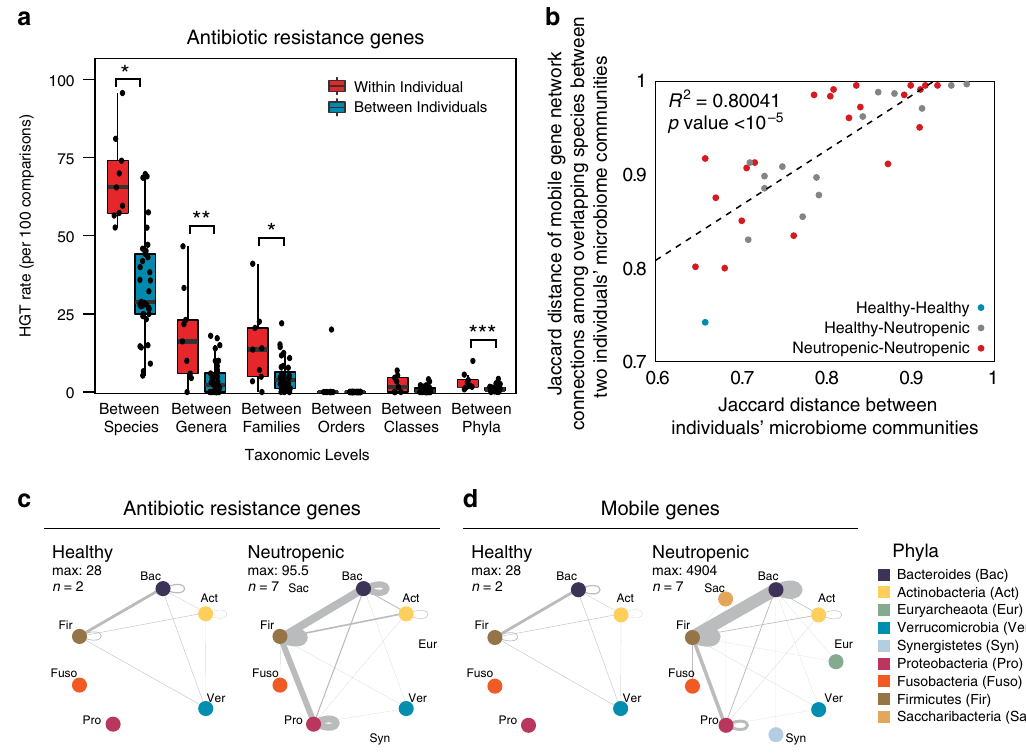
Fig. 2 Networks of bacterial HGT are unique to each individuals ’ gut microbiomes. a HGT rates (per 100 comparisons) of AR genes between organisms within each individual ( n = 9) versus between individuals ( n = 36), according to those that share the same species, genus, family, order, class, and phylum are plotted for comparison. Signi fi cance was measured with Mann – Whitney U -tests (two-sided; * p < 0.05; ** p < 0.01; *** p < 0.005. p -values are 0.0468, 0.0039, 0.0259, 0.0518, 0.1929, 0.0008, from species to phyla). Boxplot represents the interquartile range where ends of the whiskers represent ±1.5 × interquartile range and median value is indicated. b For each pair of individuals, the Jaccard distance of their composite microbiome compositions are plotted against the average Jaccard distance of the HGT network connections of mobile genes exchanged between organisms present in both individuals. Points are colored according to the health status of the donors being compared. c Network plots showing bacterial AR gene exchange according to phyla within healthy (left) and neutropenic (right) individuals ’ microbiomes. n refers to the number of people included in the plot. d Network plots showing bacterial mobile gene exchange according to phyla within healthy (left) and neutropenic (right) individuals ’ microbiomes. n refers to the number of people included in the